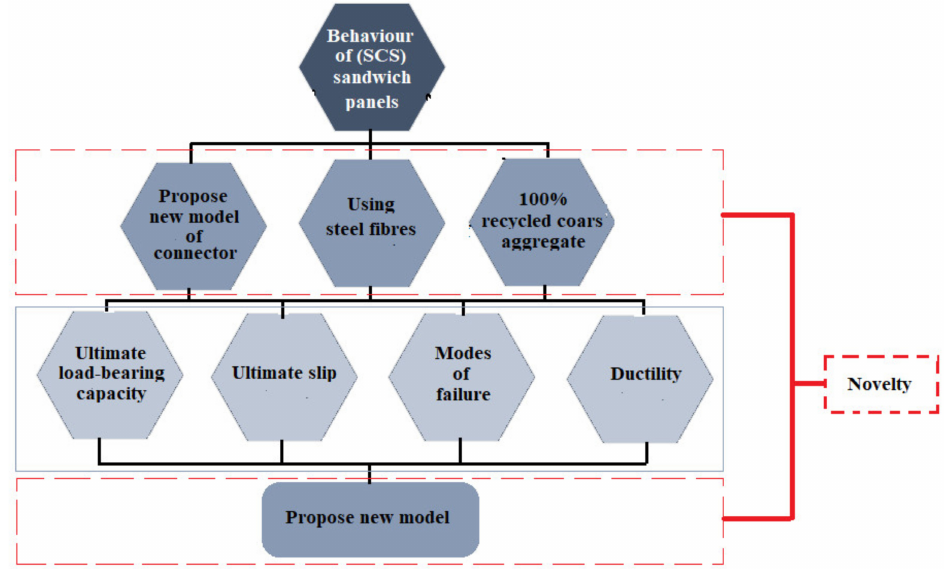
Figure 1. General flowchart of experimental program and novelty of this